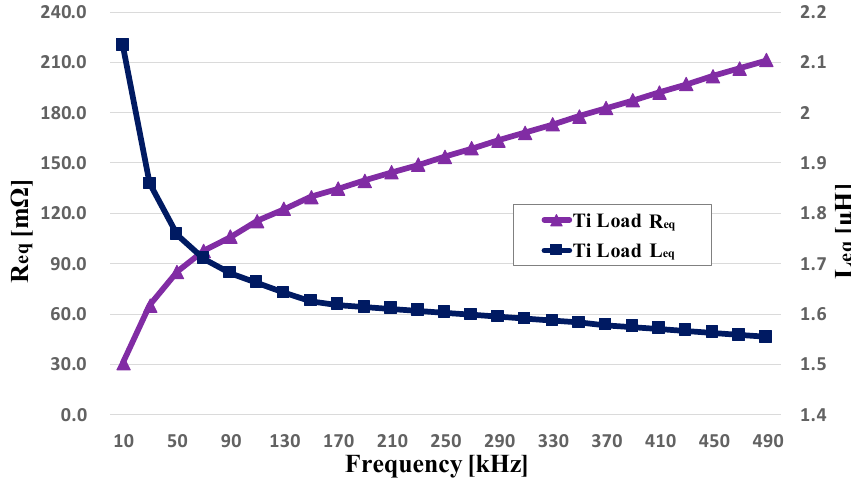
Figure 10. Parameter values of Ti load based on frequency variation.